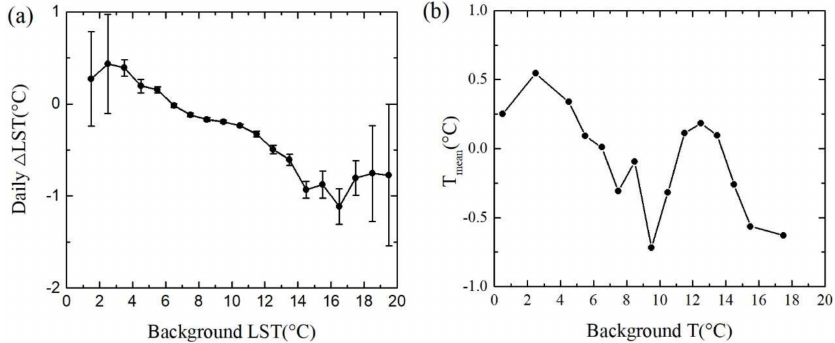
Figure 6. The relationships between ( a ) background LST and daily LST differences (forest minus open land) and ( b ) background air temperature and daily mean air temperature differences (forest minus open land). The daily LST differences are binned and averaged on 1 ◦ background LST intervals (i.e., the LST for all pixels within a window). The daily mean air temperature differences are binned and averaged on 1 ◦ grids for background air temperature (i.e., air temperatures of forest sites). The thin black bars represent the 95% confidence interval (CI) by the t